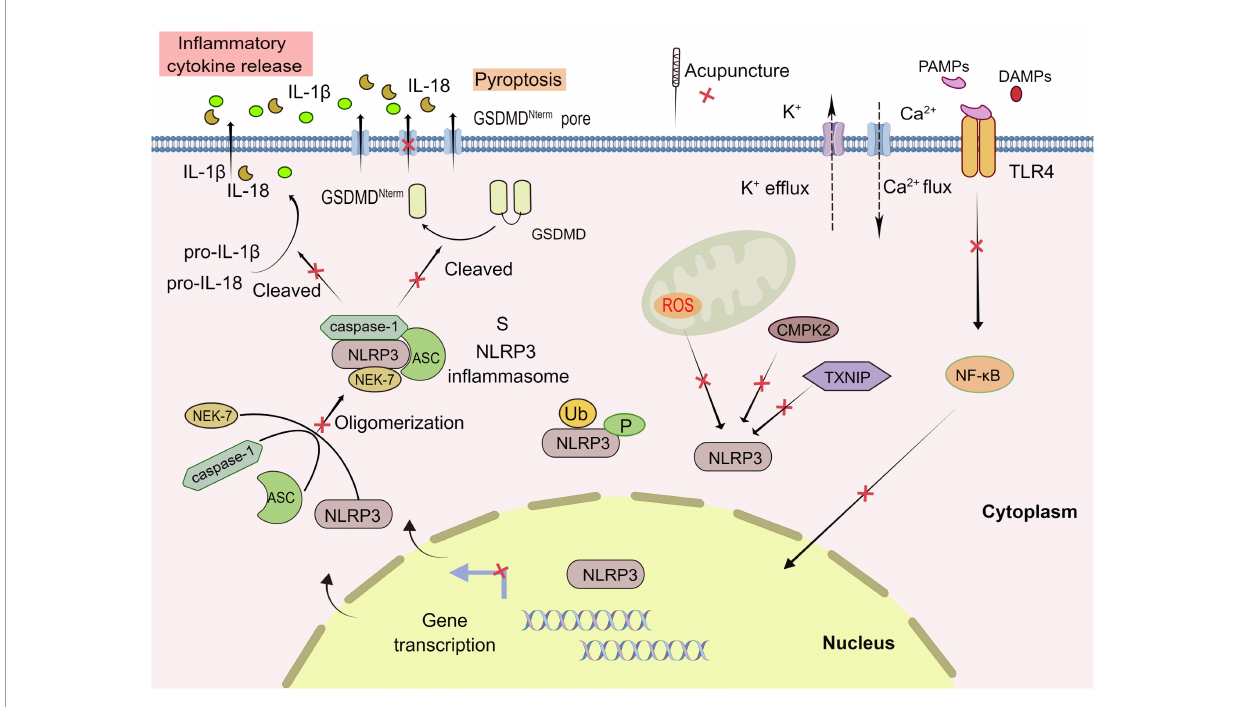
FIGURE2 Acupuncture treatment in CNS diseases based on NLRP3 inflammasome. The activation of NLRP3 inflammasome involves the assembling of the components of NLRP3 inflammasome (NLRP3, ASC, caspase-1, and NEK7) to form a complete NLRP3 inflammasome complex. PAMPs, pathogen-associated molecular patterns; DAMPs, damage-associated molecular patterns; GSDMD, Gasdermin D; ROS, reactive oxygen species. Formation of the inflammasome activates caspase 1, which in turn cleaves pro-IL-1 β and pro-IL-18. TLR, Toll-like receptor; NEK7, NIMA-related kinase 7; NF- κ B, nuclear factor- κ B; TXNIP, thioredoxin-interacting protein; CMPK2, cytosine monophosphate kinase 2; Ub, ubiquitylation; P, phosphorylation; Red X, represents a potential target for acupuncture treatment of